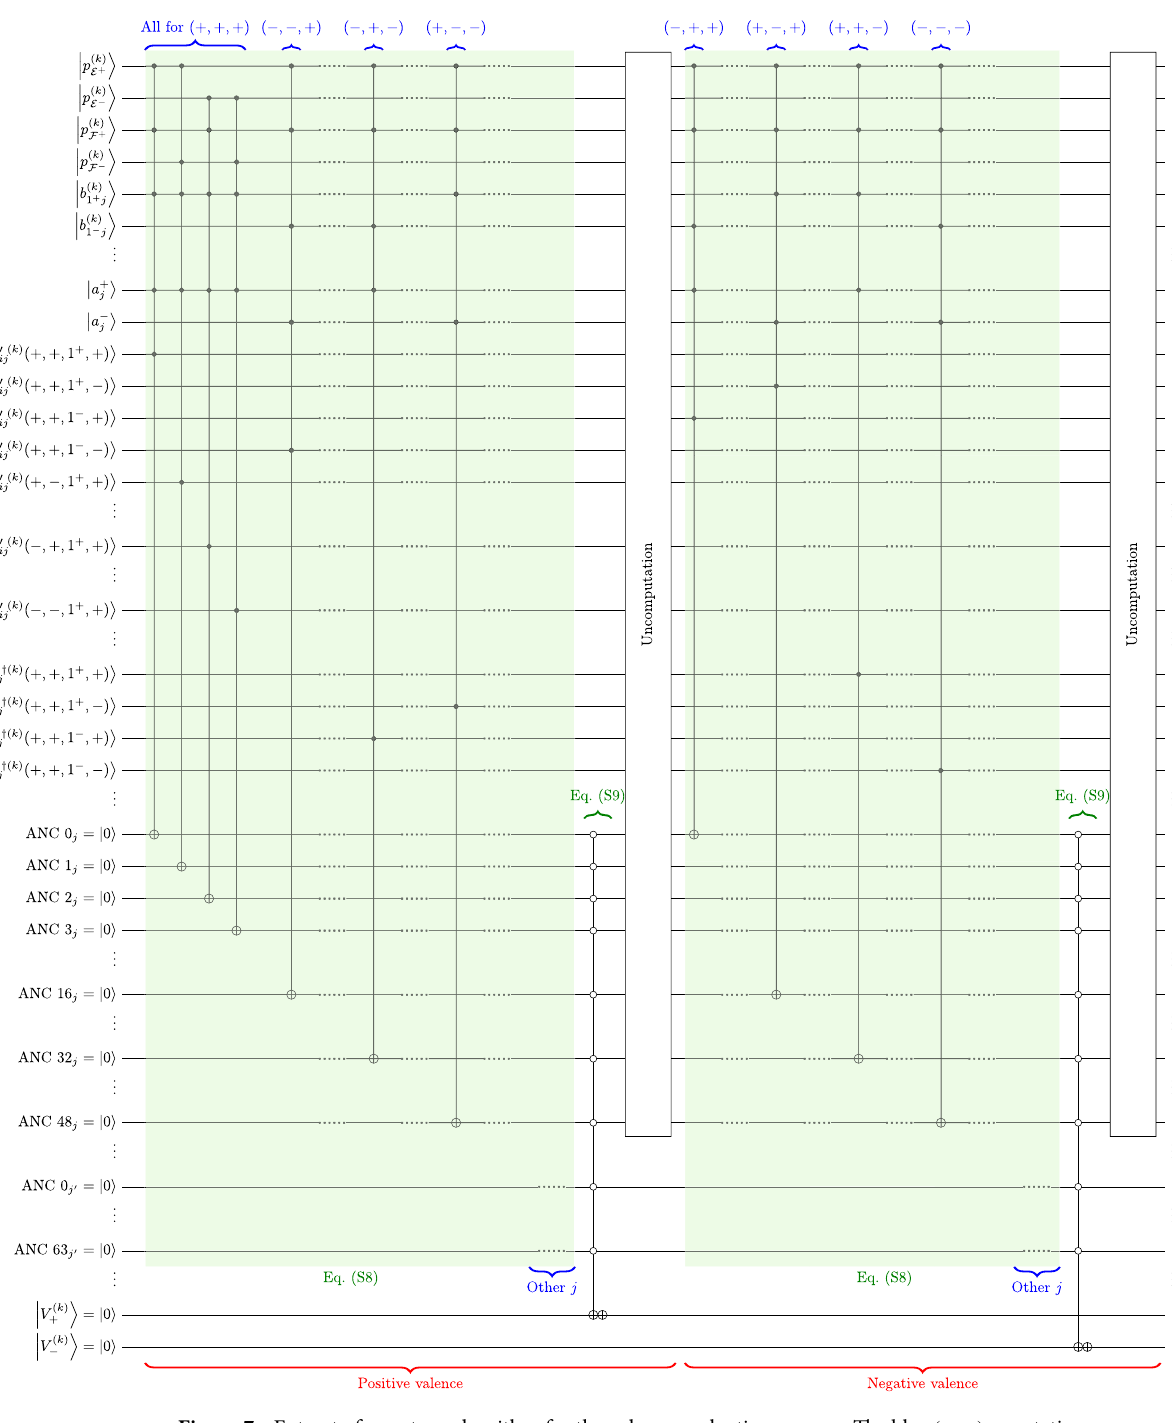
Figure 7. Extract of quantum algorithm for the valence evaluation process. The blue ( represents in sequence the indicative ( ambition ( desired / undesired ) and agreement ( agree / disagree ). All 4 combinations involving , , ( ) are depicted as an example. For other ( + + +